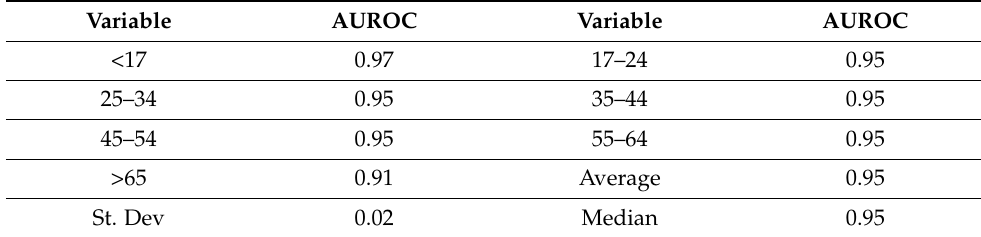
Table 5. The output variables’ area under the receiver operating curve